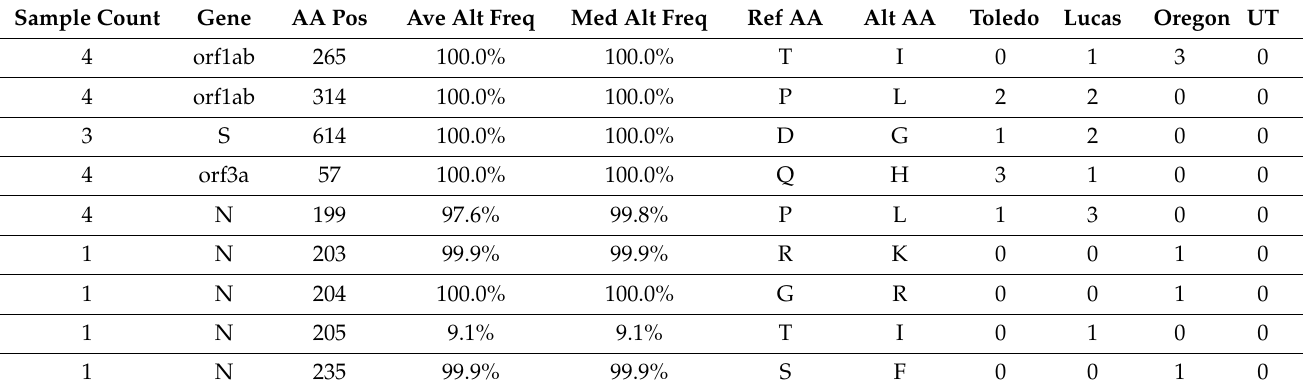
Table 1. Sample count and frequency of mutations present in the VOC and/or VOI